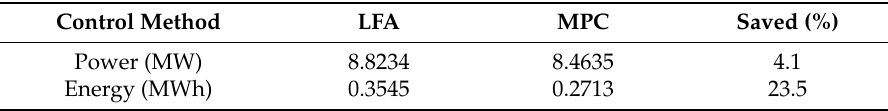
Table 2. Power and energy requirements *.